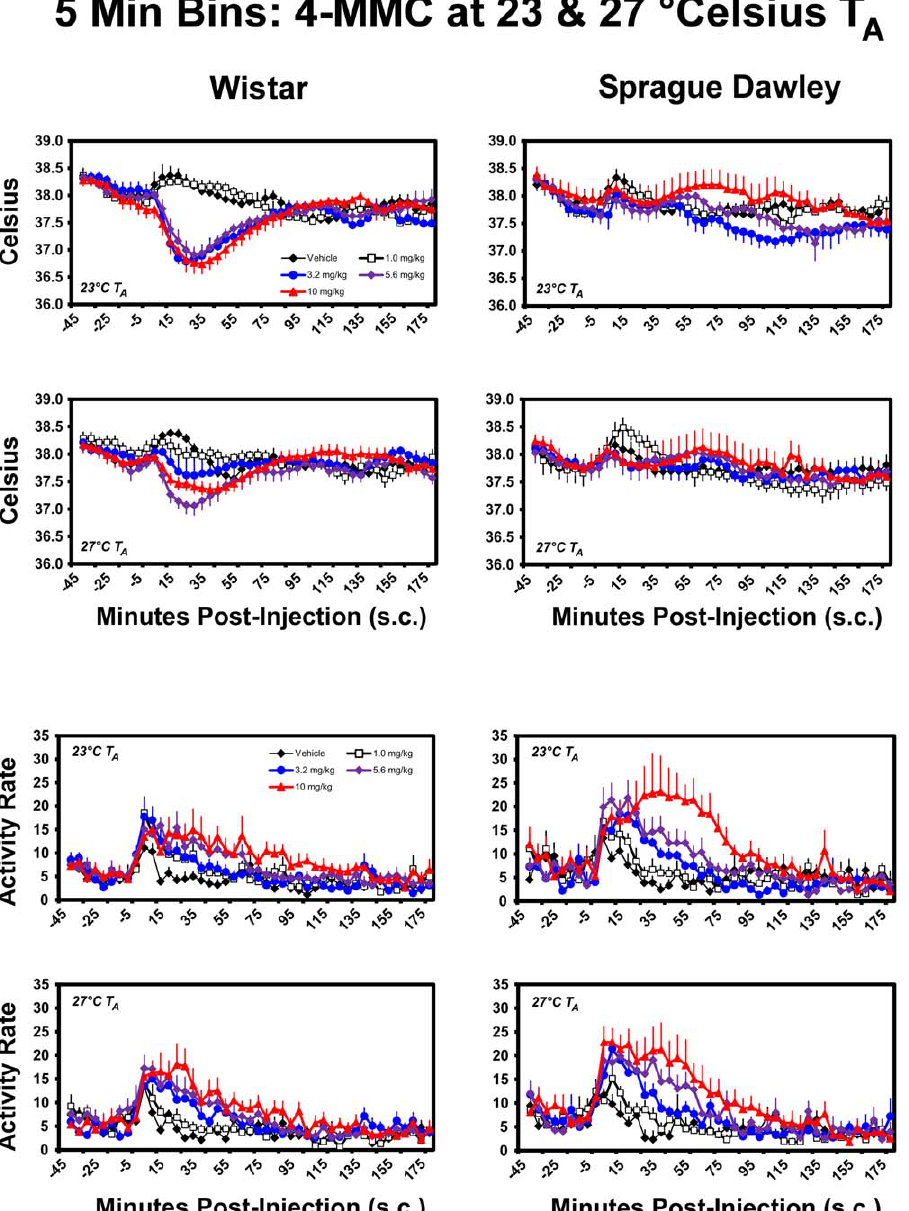
Figure 1. Mean (N=8; ± SEM) body temperature and activity rates (count/min) are presented by the 5 minute sampling interval for Wistar and Sprague-Dawley rats following challenge with 4-MMC (1.0–10.0 mg/kg, s.c.) and vehicle under 23 6 C and 27 6 C T A conditions.